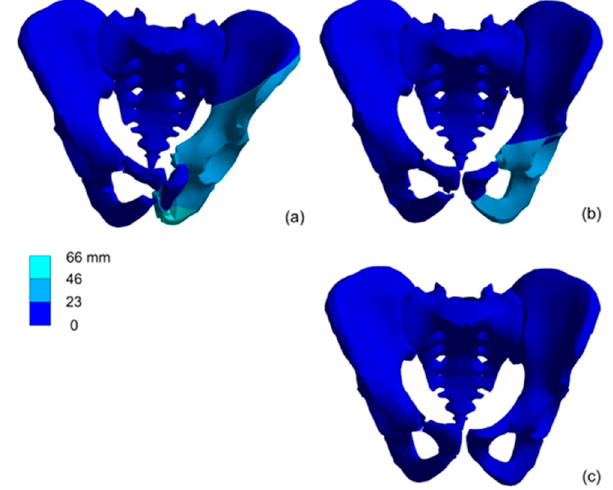
Figure 7. Displacements in the pelvis model for first support case for load impulse period time: ( a ) 4 ms, ( b ) 2 ms, ( c ) 1 ms.